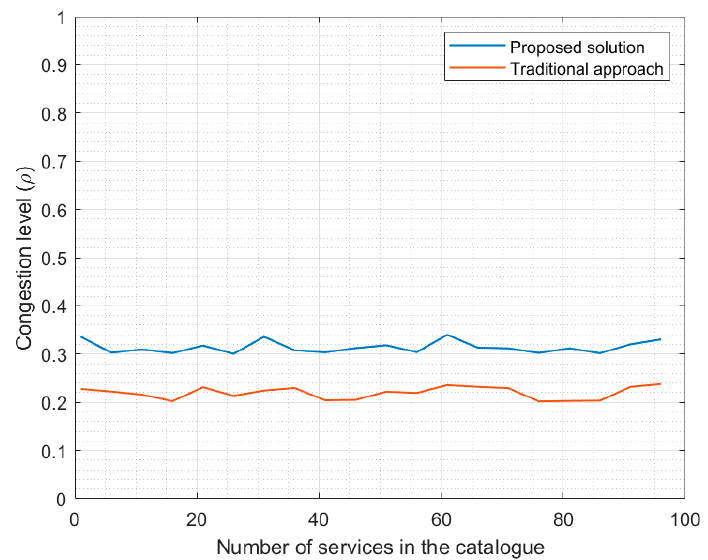
Figure 8. First experiment: congestion level.